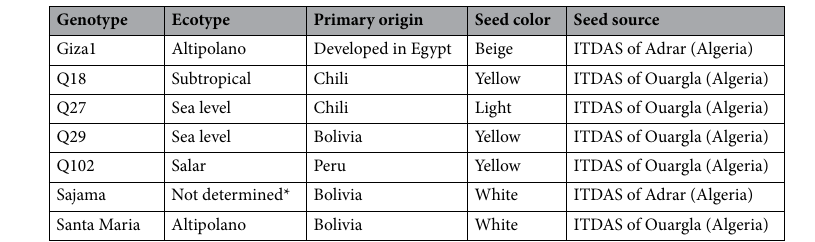
Table 2. Some characteristics of the tested quinoa genotypes. *According to 32,69,78